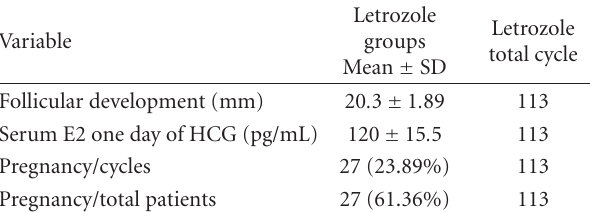
Table 4: characteristics of letrozole